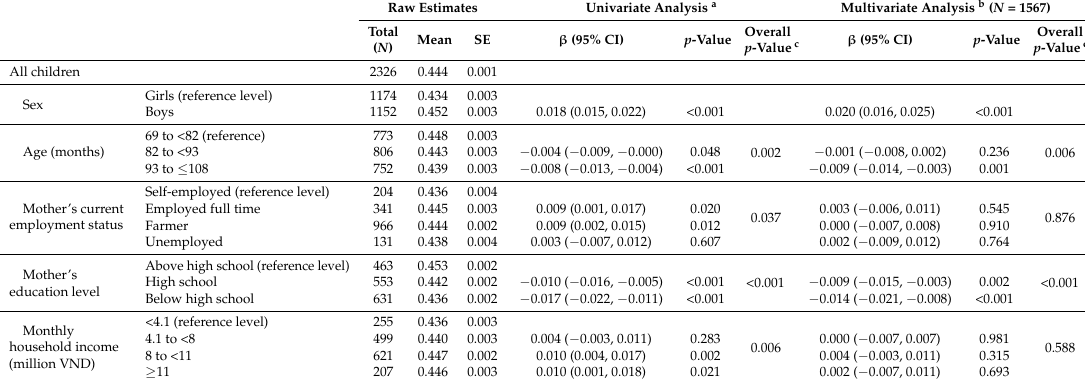
Table 9. Waist-to-Height Ratio and associated socio-demographic factors in 6–9-year-old children in rural areas of Vietnam.